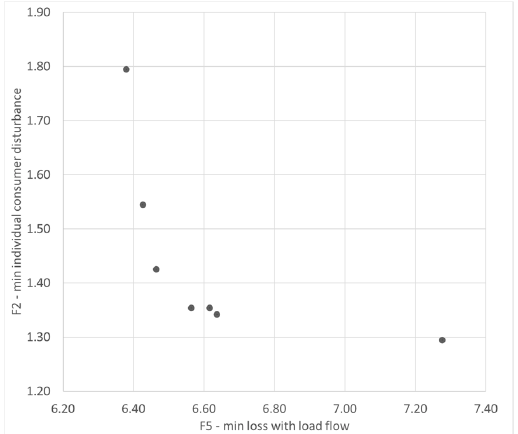
Figure 4. The Pareto frontier for the pair F5–F2.